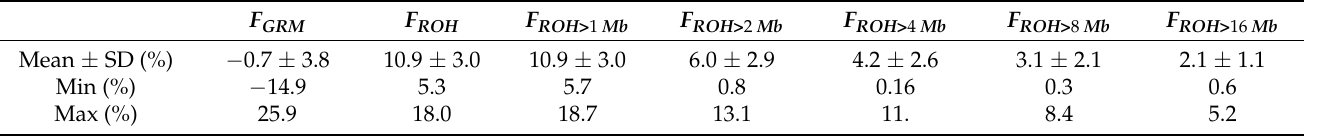
Table 2. Different inbreeding coefficients based on genomic information ( F GRM and F ROH ) 1 in the TMC cattle